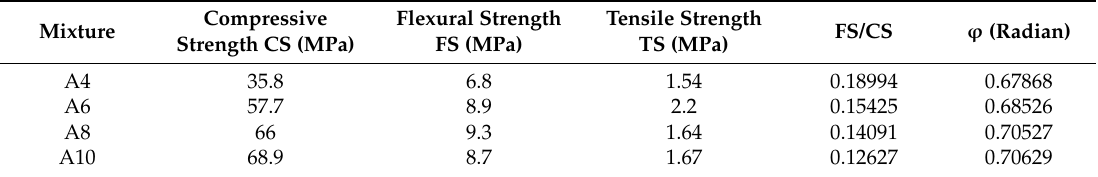
Table 2. Mechanical strength, ratio of flexural strength to compressive strength (FS/CS) and internal friction angle ( ϕ ) of AAS mortar at 28